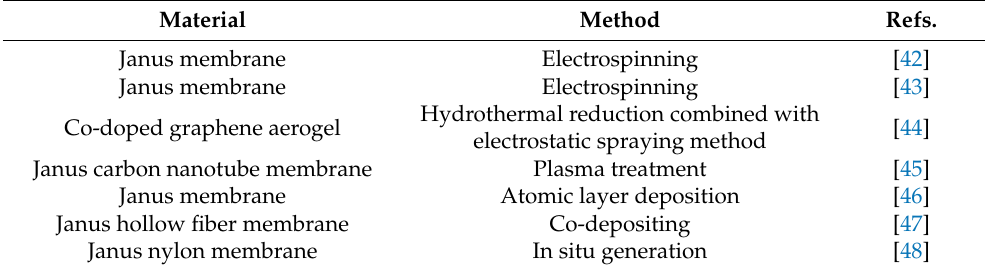
Table 1. Various preparation methods of Janus materials with asymmetric wettability for oil–water